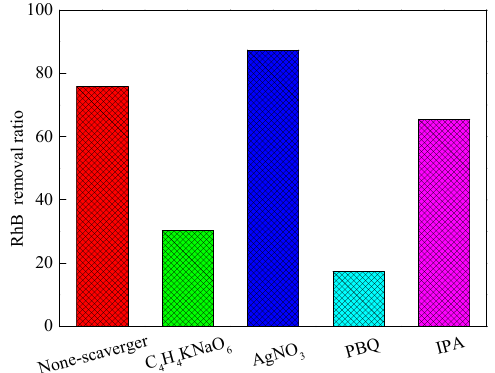
Figure 6. Scavenger effect of sample 8 photocatalyst.